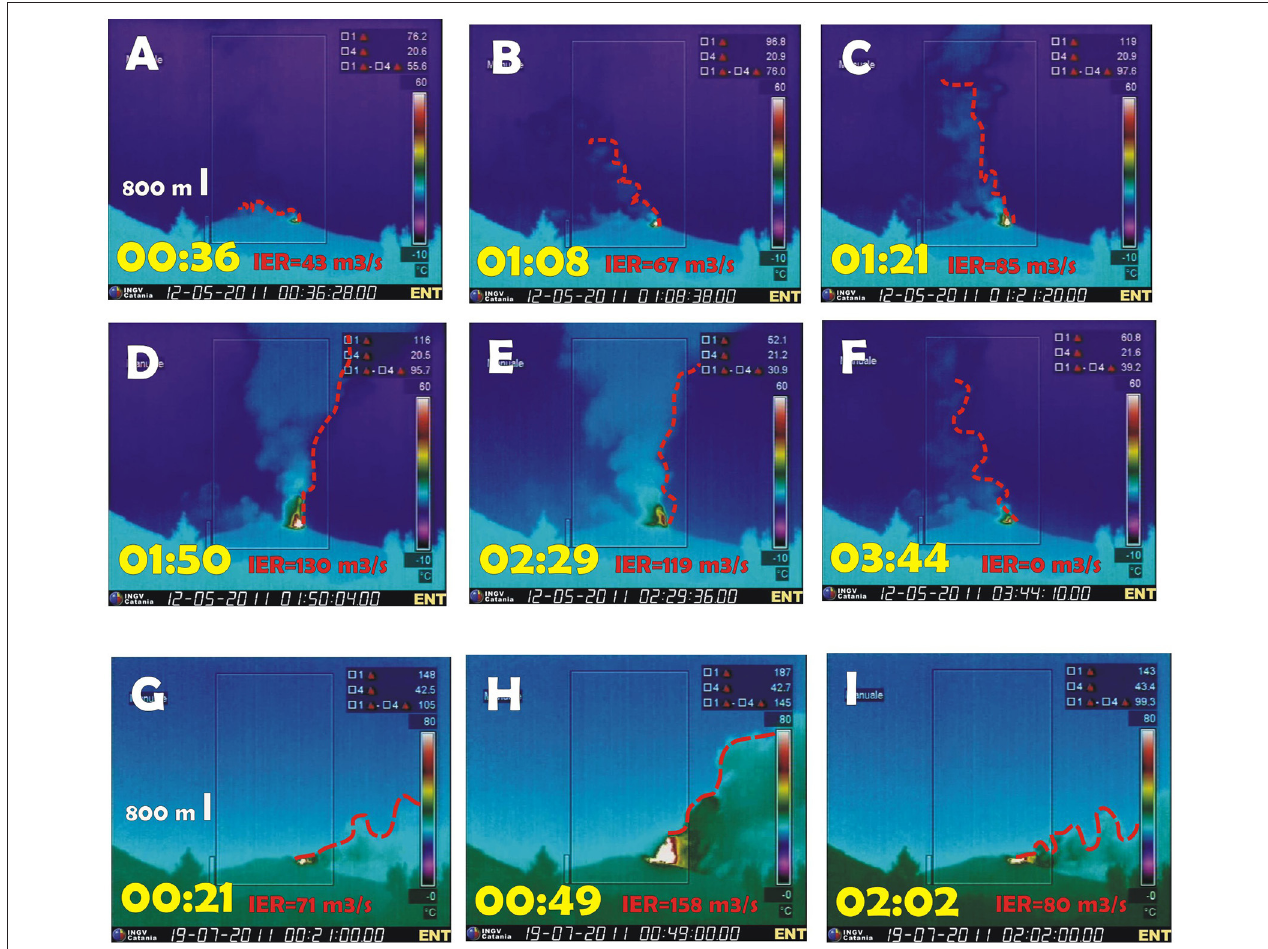
FIGURE 6 | Thermal images recorded by the fixed camera of Nicolosi, south flank of the volcano (ENT, see Table 2 for details), showing the variability of the plume inclinations (bounded by the red striped line) for the episode of 12 May 2011 (A–F) , producing a strong plume (D,E) , and for the episode of 19 July 2011 (G–I) , giving rise to a weak plume. Eruption parameters are in Table 1 . In yellow is time (UT), in red Instantaneous Effusion Rate (IER; Harris et al., 2007). The vertical white line in (A,G) is for scale. See text for further